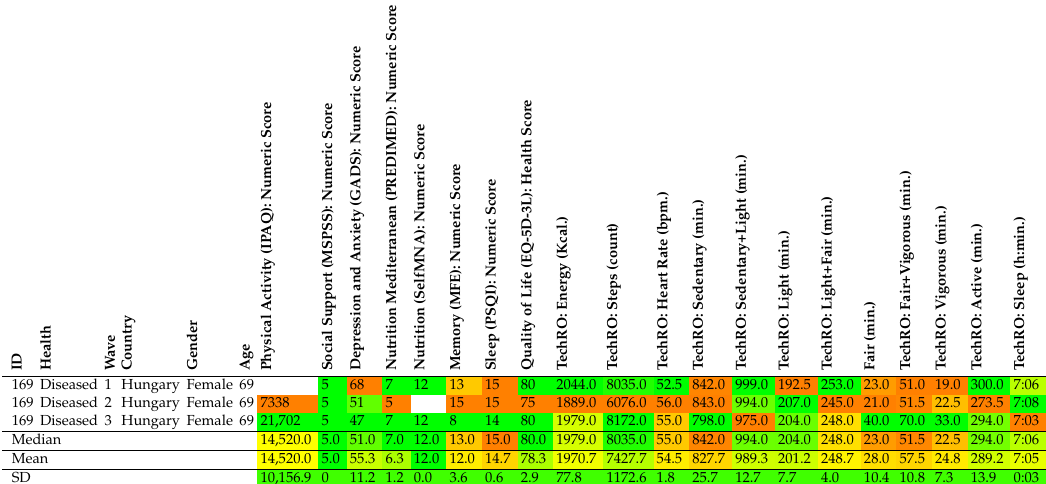
Color coding: from orange (worse outcome) to yellow to green (better